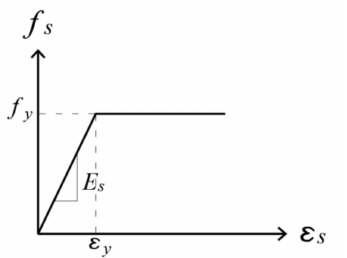
Figure 4. Steel material